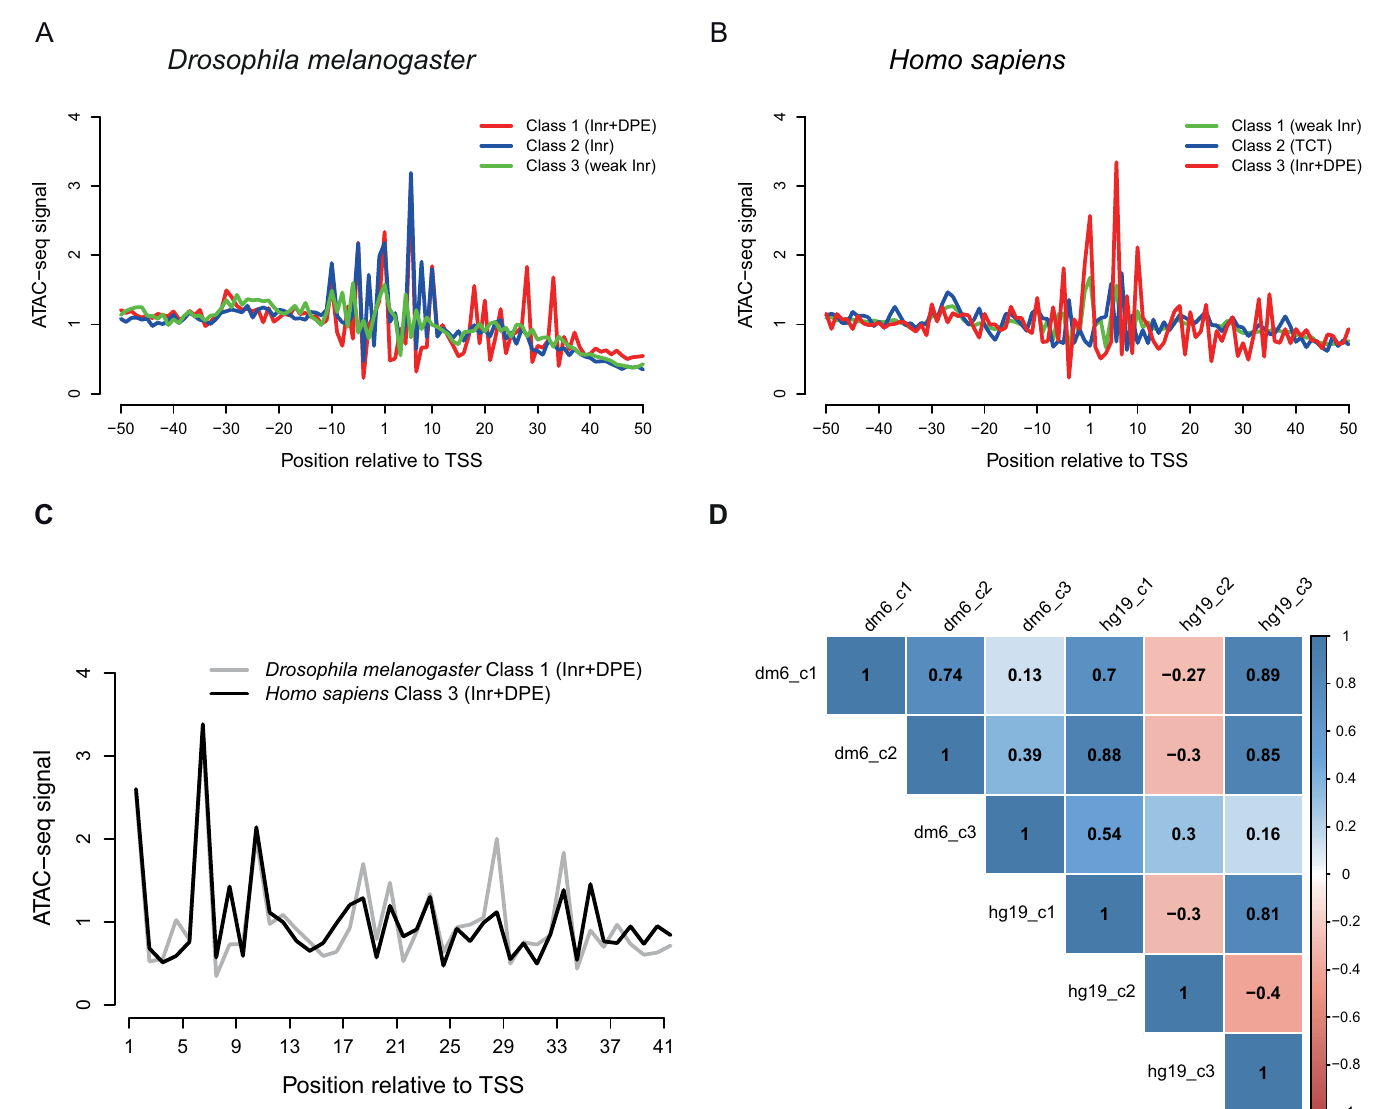
Fig 4. ATAC-seq footprints of different promoter classes. Single-base resolution ATAC-seq footprints are shown for the three most prominent promoter classes (Figs 2 and 3) in Drosophila (A) and Homo sapiens (B). (C) Enlarged footprints of the proximal promoter downstream regions of the two Inr+DPE classes are combined in one plot to facilitate cross-species comparison. (D) Pearson correlation coefficients computed from the same proximal promoter regions are shown for all possible pairs of promoter classes. The ATAC-seq signal displayed on the vertical axis of all line plots is expressed as fold enrichment over the local mean ( i . e . for each line, the points were first divided by their mean before plotting). Numerical data are provided in S2